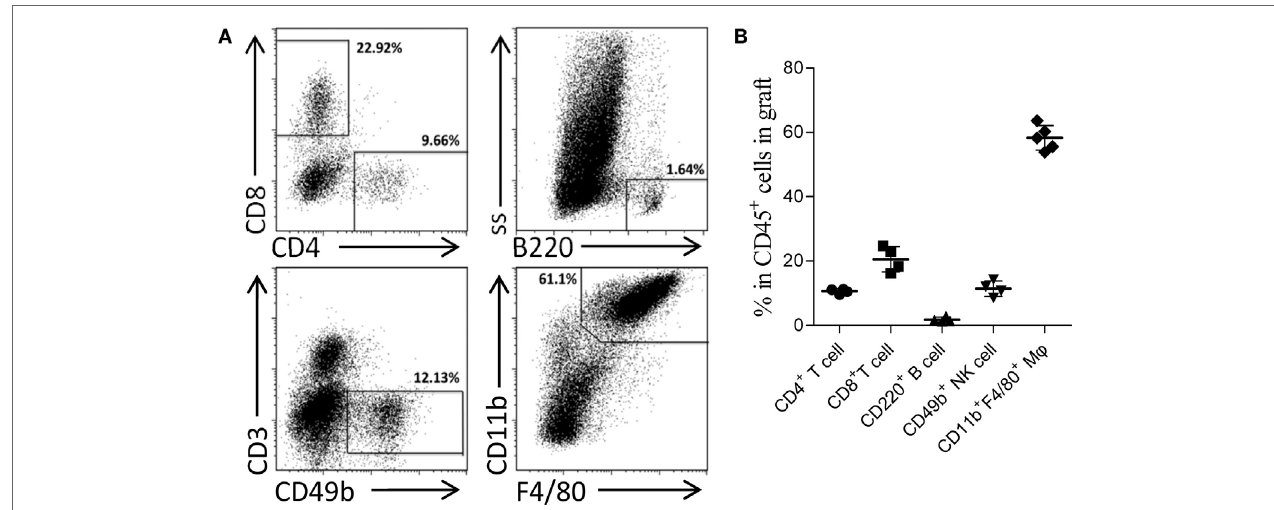
FigUre 3 | Acute antibody-mediated rejection (AMR) established by performing kidney transplant at early stage after skin priming was concomitant with a high ratio of graft-infiltrating macrophages. Balb/c recipient mice were primed with C3H donor skin grafts for 4 days prior to receiving the C3H kidney transplant to establish the AMR model. On day 5 after kidney transplantation, the phenotypes of CD45 + immune cells infiltrated in the kidney graft were determined by flow cytometry. (a) Representative dot plots of CD11b + F4/80 + macrophages, CD8 + T cells, CD49b + NK cells, CD4 + T cells, and CD220 + B cells. (b) Macrophages form the most prominent population in the kidney graft, followed by CD8 + T cells, NK cells, CD4 + T cells, and B cell subsets. The results represent the mean ± SD of at least four independent